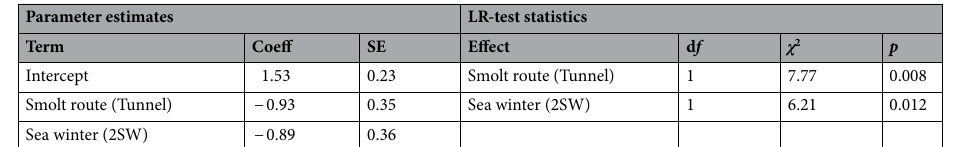
Table 2. Logit-parameter estimates and corresponding likelihood-ratio test statistics for the most supported GLM model fitted to predict probabilities for Atlantic salmon spawners to ascend the minimum flow stretch for induviduals that migrated through two different routes as smolts (minimum flow stretch or hydropower tunnel) and spendt one (1SW) or two (2SW) winters at sea before returning to spawn in River Nidelva.